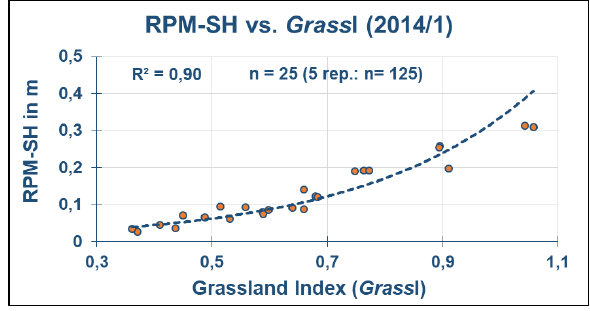
Figure 6. Relationship of RPM-SH and Grass I data